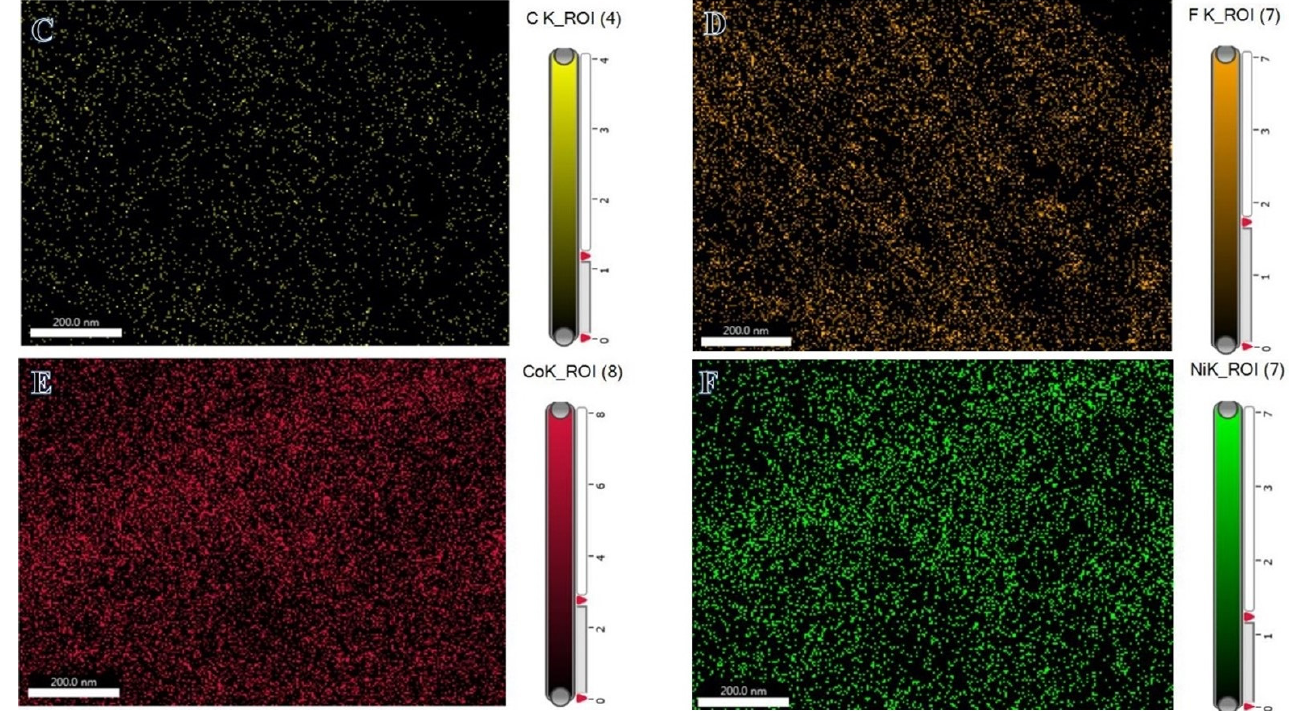
Figure 3. EDX chart of Ni 0.3 Co 0.7 @PVDF ‐ co ‐ HFP NFs membrane ( A ) and mapping showing the spread of elements ( B ), carbon ( C ), fluorine ( D ), cobalt ( E ), and nickel ( F ) in the Ni 0.3 Co 0.7 @PVDF ‐ co ‐ HFP NFs.